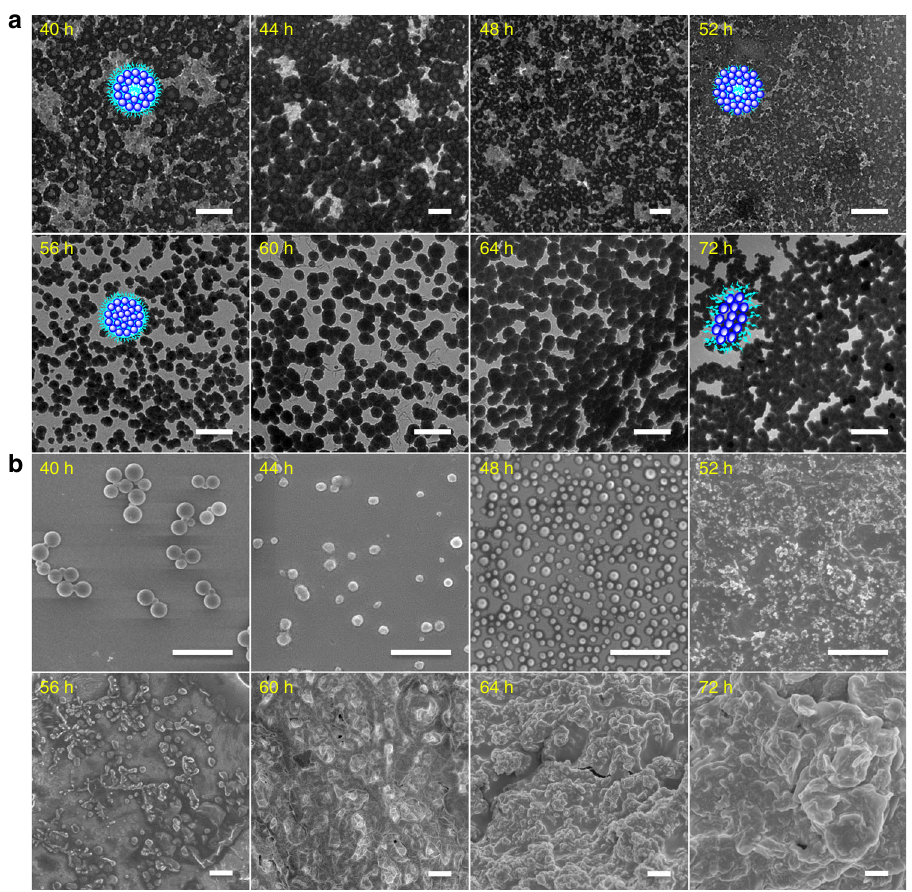
Fig. 7 Hierarchically nanostructural bending, cyclization, and radial connection at microscales and macroscales. After neutralizing the aqueous solution and removing the by-products before dialysis, all the samples are prepared from the neutralized aqueous solution unless otherwise noted. a TEM and b SEM images showing self-assembled evolution of POSS-SS-(PEG) 8 with the concentration of 1 mg/mL in pH 8 aqueous solutions for various times. Insets are the correspondingly schematic structures. Scale bars: 0.5 μ m. The formation of hollow spheres veri fi es the nanostructural bending and cyclization mechanism. The reduced size of vesicle cavity demonstrates the inner circumferential crosslinking process, and the following spherical and elliptic aggregates con fi rm the periodically axial growth pathway even on the microscales and macroscales, which indicates the achievement of hierarchical self-assembly strategy for the guiding the morphology and size evolution from the nanoscopic solution aggregates to the microscopic and macroscopic hydrogel